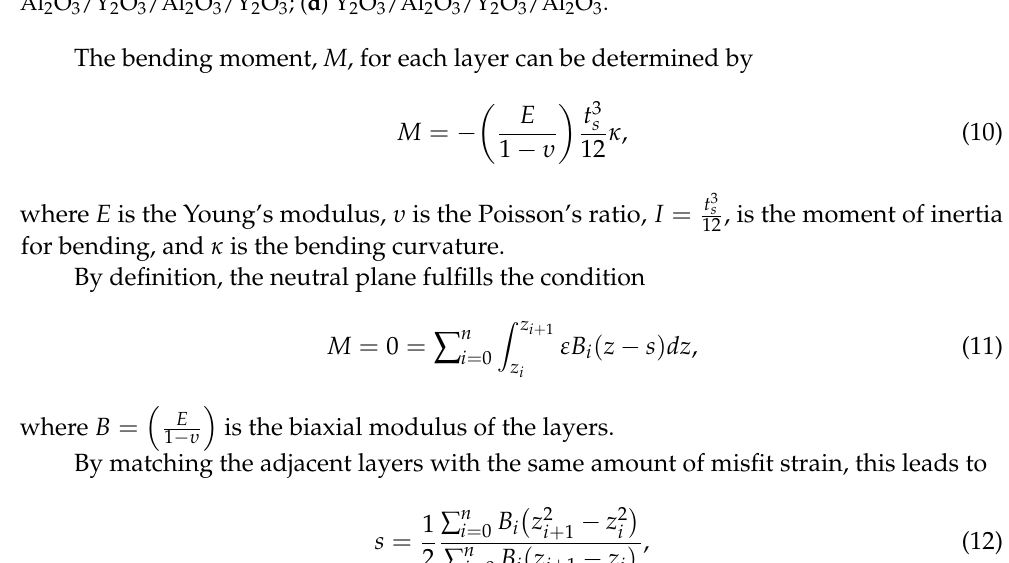
Figure 8. Equivalent elastic strain in laminated coatings: ( a ) Al 2 O 3 /Y 2 O 3 ; ( b ) Y 2 O 3 /Al 2 O 3 ; ( c ) Al 2 O 3 /Y 2 O 3 /Al 2 O 3 /Y 2 O 3 ; ( d ) Y 2 O 3 /Al 2 O 3 /Y 2 O 3 /Al 2 O 3